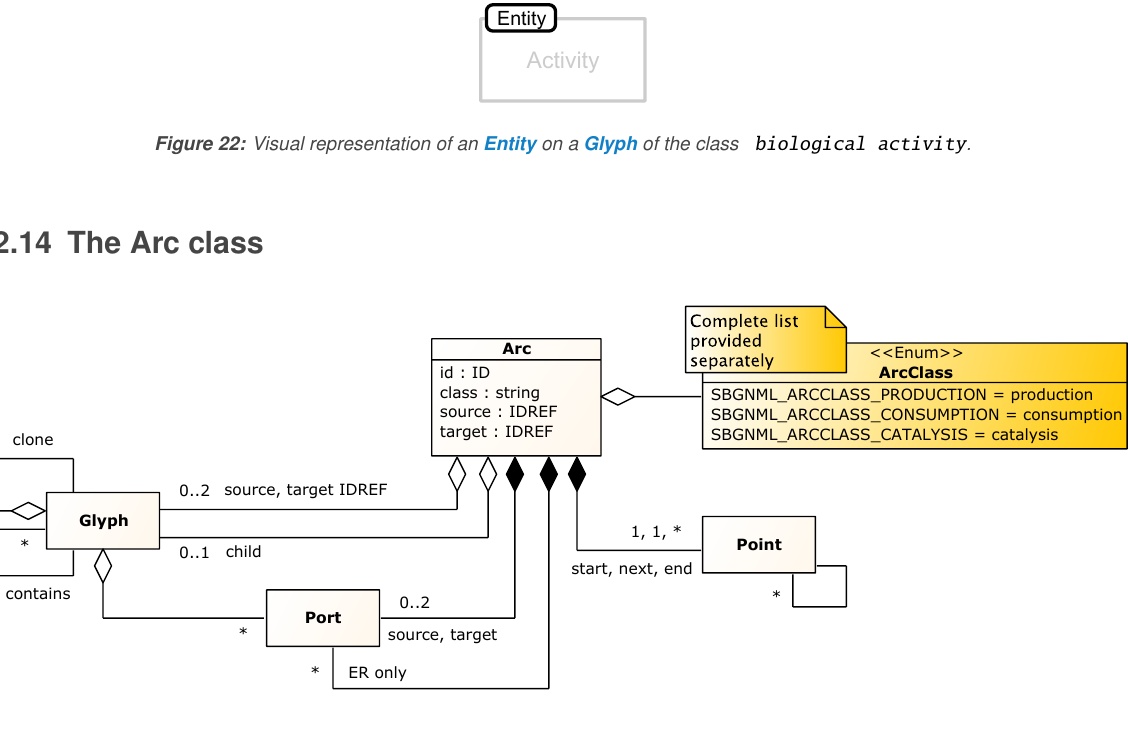
Figure 23: A UML representation of the Arc class for the Systems Biology Graphical Notation - Markup Language. See Section 2.1 for conventions related to this figure.